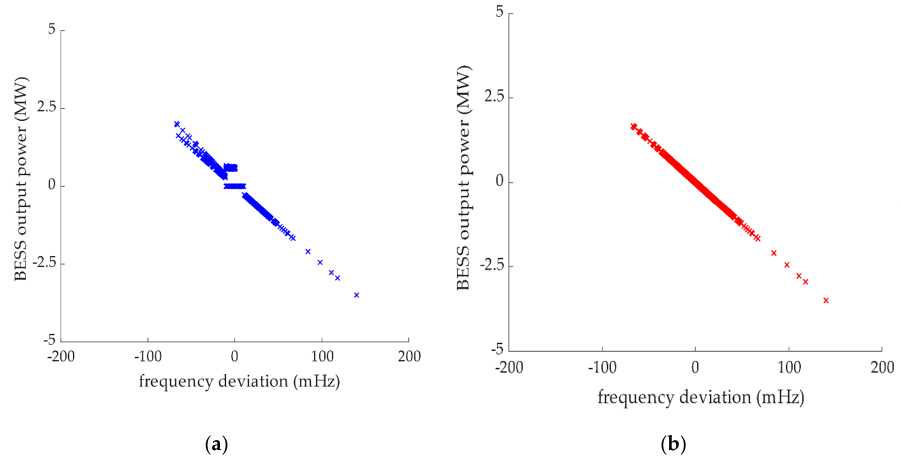
Figure 15. ( a ) Working power to frequency ratio ( Δ P- Δ f ) characteristics of the BESS operation during